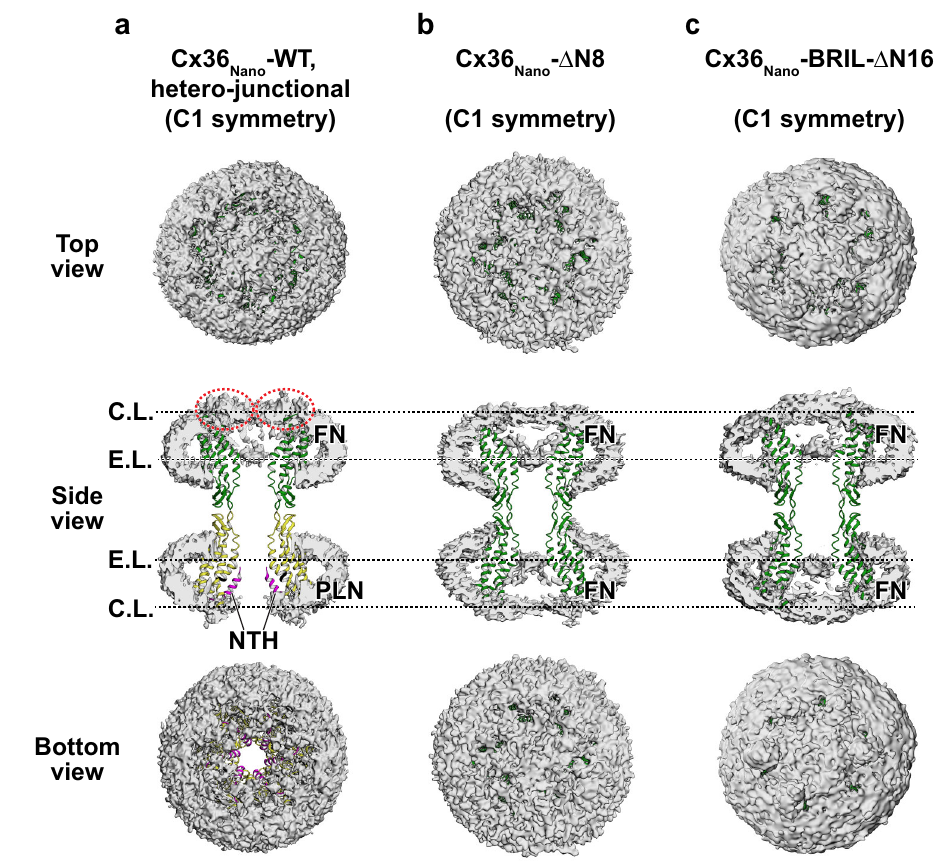
Fig. 4 | Structural characterization of the pore-occluded state in lipid nano- discs. a – c Top, cross-sectioned side, and bottom views of the cryo-EM recon- structionmapwithC1symmetryimposition.Ribbonrepresentationsofthehetero- junctional Cx36 Nano -WT ( a ), Cx36 Nano - Δ N8 ( b ), and Cx36 Nano -BRIL- Δ N16 ( c ) GJCs are also shown. C.L. and E.L. denote cytoplasmic layer and extracellular layer,